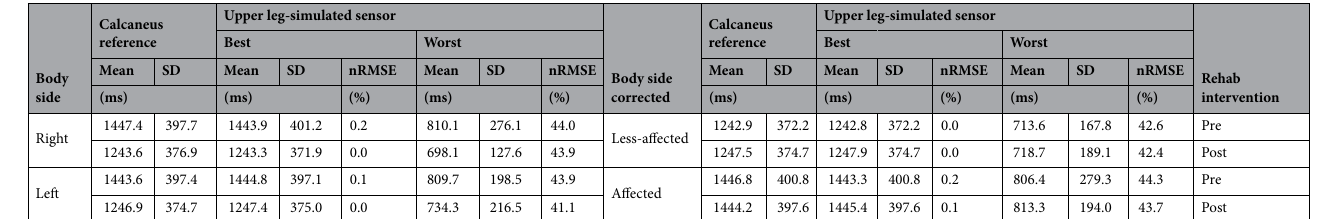
tions at the affected and less-affected upper leg for pre- and post-intervention data of one patient. The less- affected upper leg yields a larger error-free area at the ventral and medial side compared to the affected side. Comparison between pre- and post-intervention show that the error-free area increases for both body sides in post-intervention. Personalised sensor positions in patient study. A common “best practice” is that sensors are symmetrically posi- tioned on each body side, which ignores the functional differences in hemiparetic patients. Figure 8 illustrates effects of simulated sensor positions at left and right body side compared to positions corrected for each patient’s affected and less-affected sides. To better quantify the study intervention effect, we highlight nRMSE map areas with an nRMSE 10%. Six out of eight patients, had an affected right side, which is influencing the right body ≤ nRMSE map shown as a comparably small region of nRMSE 10%. Correspondingly, the left body nRMSE ≤ map was mainly derived from strides of the less-affected side, which reflects in the larger region of nRMSE ≤ 10%. When correcting for affected and less-affected body sides, the less-affected side showed a ventral area with nRMSE 10% prior to the intervention. In comparison, the affected side had a smaller region of nRMSE 10%. ≤ ≤ After the intervention regions with nRMSE 10% increased for both body sides while for the affected side a shift ≤ of the region to the medial-dorsal was observed. We analysed stride duration derived from the best and worst simulated sensor position at the upper leg to investigate the nRMSE range, when correcting for affected and less-affected body sides. Results are summarised in Table 2. Across the patient population, the best simulated sensor showed nRMSE below 0.25%, where correct- ing for affected and less-affected body sides had negligible effect on estimation performance. In contrast, stride duration nRMSE went up to 44.26% for the worst performing simulated sensor position. For the best sensor positions, nRMSE based on pre-intervention data were higher at the affected (avg. 0.24%) than the less-affected side (0.01%). From post-intervention data, we observed similar nRMSE on the affected (avg. 0.08%) and less- affected side (avg. 0.03%).